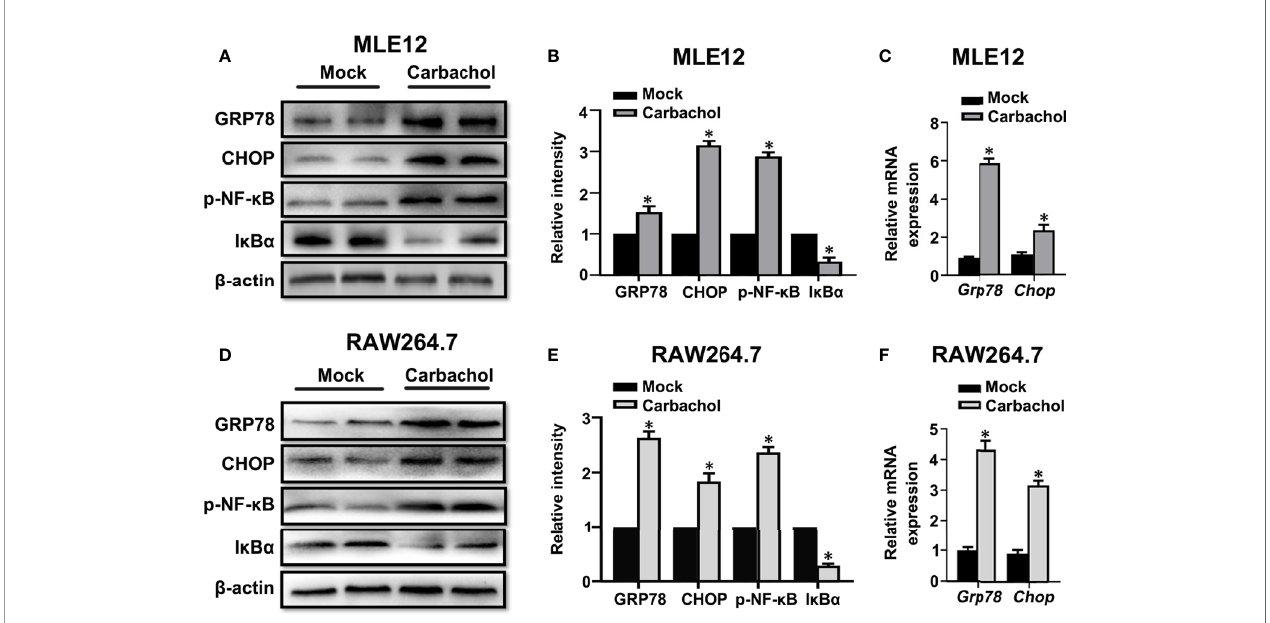
FIGURE 10 | Carbachol stimulates ER stress in lung epithelial cells and macrophage. (A, B) Representative immunoblots of GRP78, CHOP, p-NF- k B p65 and I k B a in MLE12 cells and densitometric analyses of GRP78, CHOP, p-NF- k B p65 and I k B a . MLE12 cells were treated with 50 m M carbachol or non-treated for 24h. (C) Levels of GRP78, CHOP mRNA in MLE12 cells. (D, E) Representative immunoblots of GRP78, CHOP, p-NF- k B p65 and I k B a in RAW264.7 cells and densitometric analyses of GRP78, CHOP, p-NF- k B p65 and I k B a . RAW264.7 cells were treated with 50 m M carbachol or non-treated for 24h. (F) Levels of GRP78, CHOP mRNA in RAW264.7 cells. Data are expressed as means ± SD from 3 independent experiments. * P < 0.05 vs . Mock